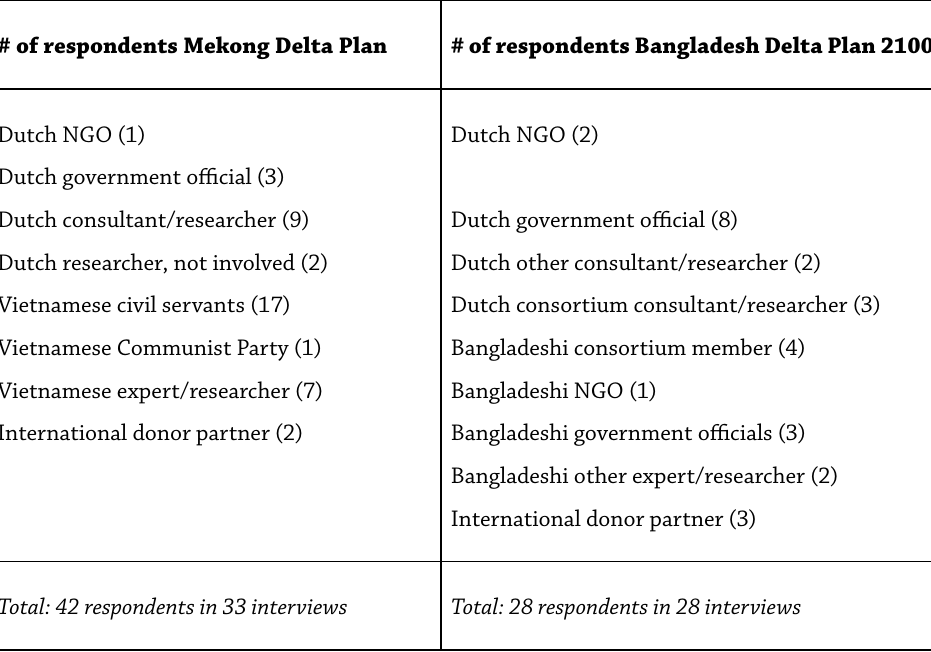
Table 2. Overview of interviews conducted in both cases between 2016 and